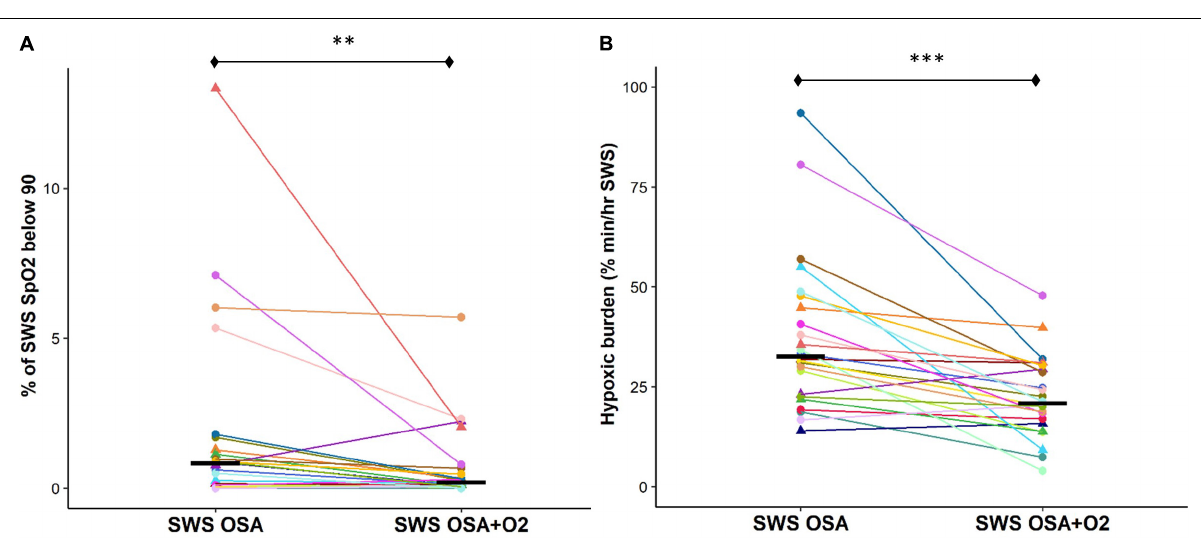
FIGURE 3 | Supplemental O 2 during CPAP therapy withdrawal results in a less cumulative SpO 2 desaturation during SWS. Cumulative SpO 2 desaturation is significantly reduced with the addition of supplemental oxygen as shown by a reduced time during SWS when SpO 2 values were below 90% (A) and hypoxic burden measures are lower (B) . All 24 participants are represented by different colors with a triangle indicating female. Median values for each condition are shown as a solid black line. n.s., not significant; **** p < 0.0001, *** p < 0.001, ** p < 0.01 and * p <